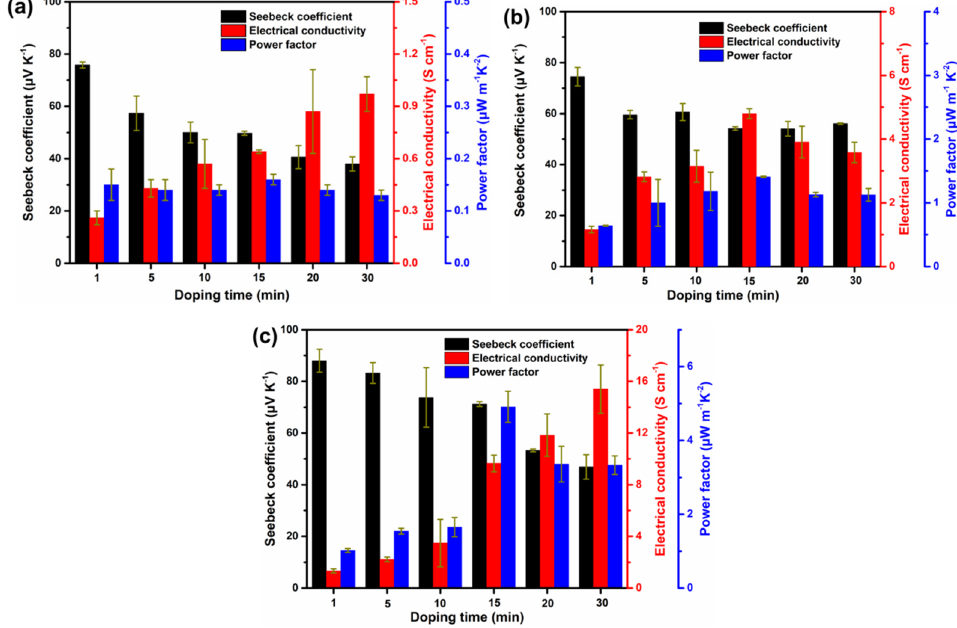
Figure 6. Thermoelectric performance for P1 ( a ), P2 ( b ), and P3 ( c ) films with different doping times / acetonitrile) at room (immersed in the 0.1 M FeCl 3 /acetonitrile) at room temperature. (immersed in the 0.1 M FeCl 3